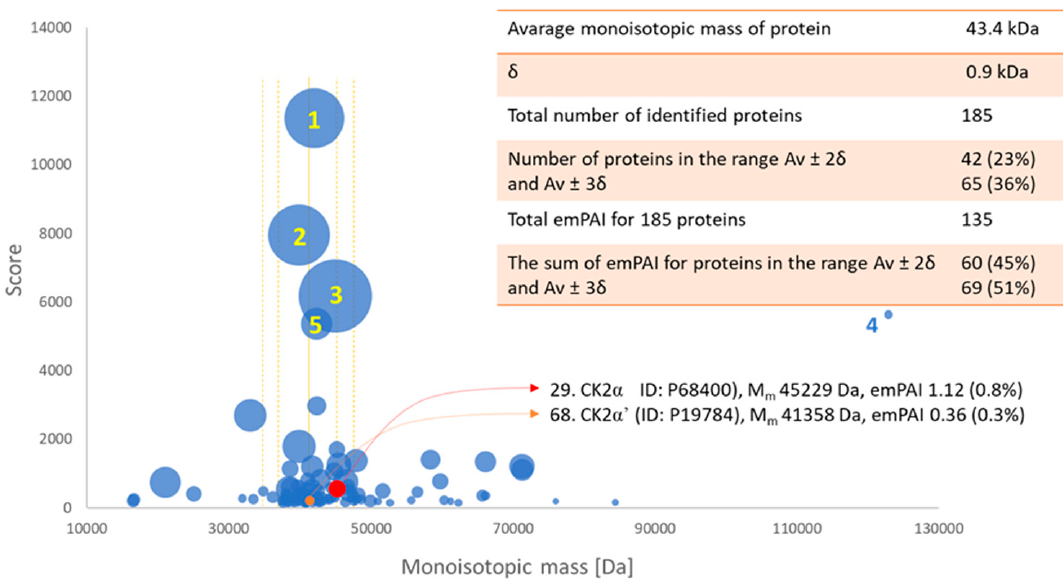
Figure 6. The molecular weight distribution of the proteins in the excised gel band against the Score describes the probability of matching experimental data with proteins in the database. The bubble size corresponds to emPAI value—the parameter dependent on the protein concentration. Most abundant proteins are indicated with numbers: 1. Actin cytoplasmic 1/2, 2. Fructose-bisphosphate aldolase A, 3. Phosphoglycerate kinase 1, 4. POTE ankyrin domain family member E, 5. Actin, alpha cardiac muscle.